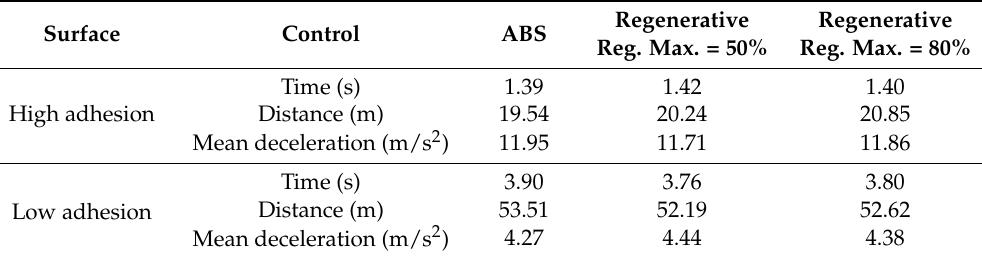
Table 5. Comparison ABS vs. Regenerative